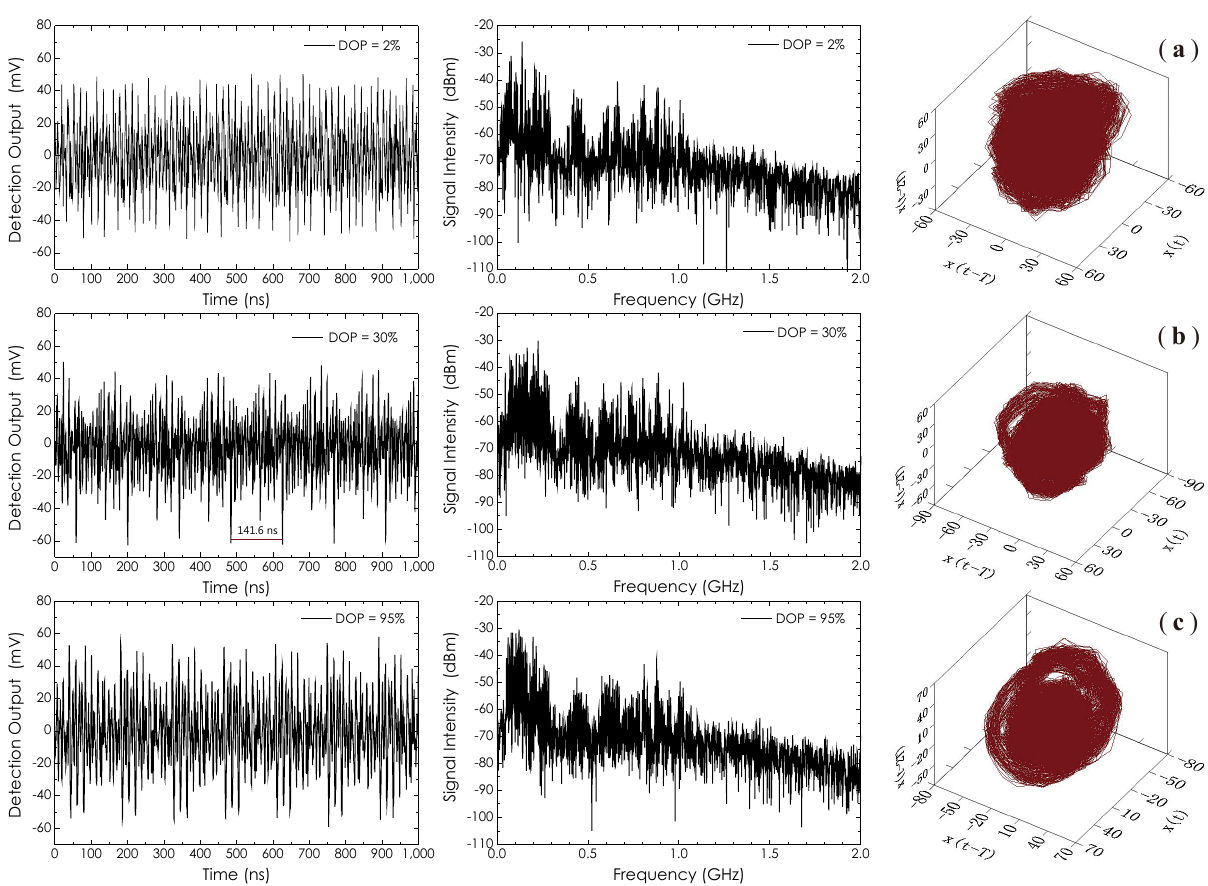
Figure 7. Time waveforms, frequency spectra of the output beam at different DOP values, as well as corresponding phase space trajectories with a delay T = 7 , where: ( a ) DOP = 2%; ( b ) DOP = 30%; and ( c ) DOP = 95%.